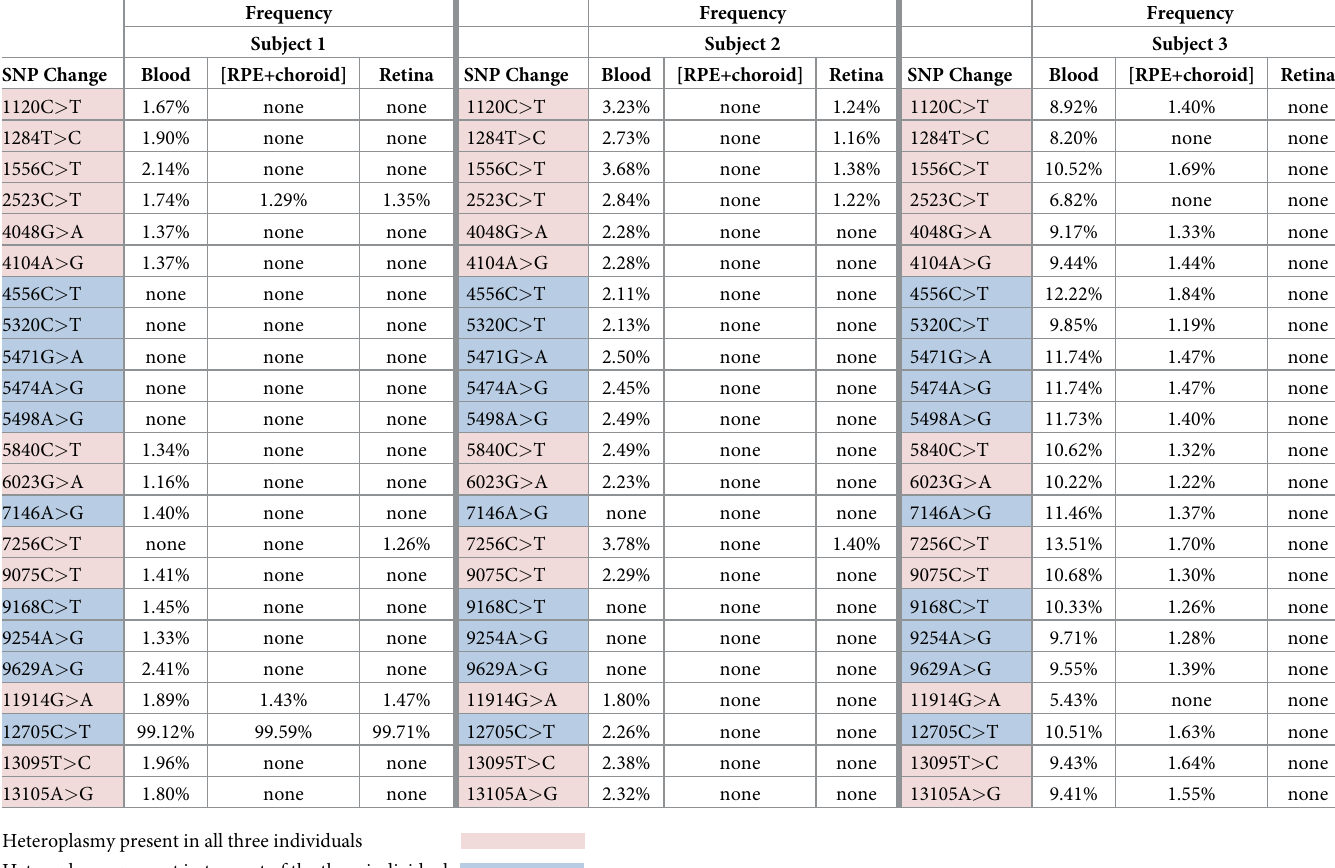
Table 6. Top 23 heteroplasmy SNPs: